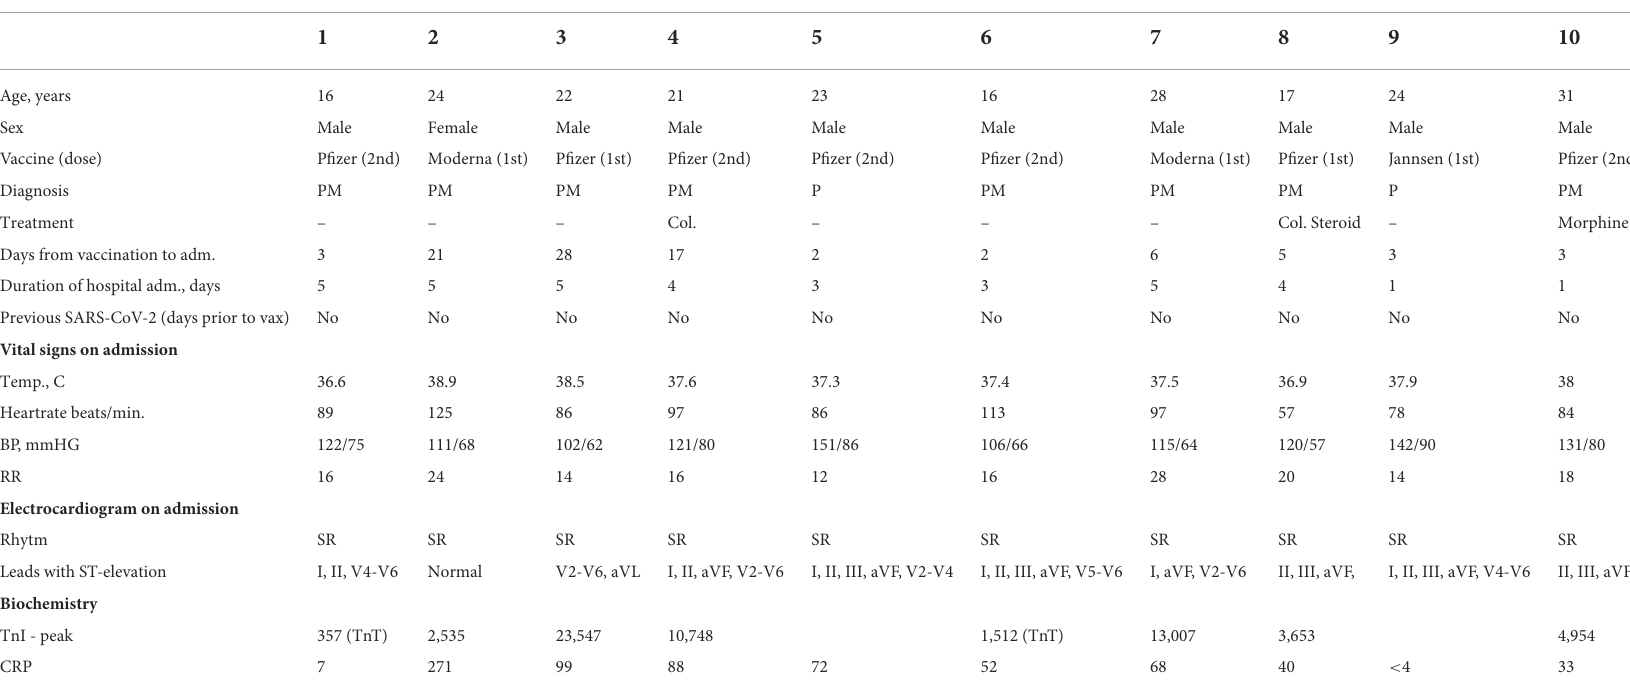
TABLE 1 Demography, vital signs, and